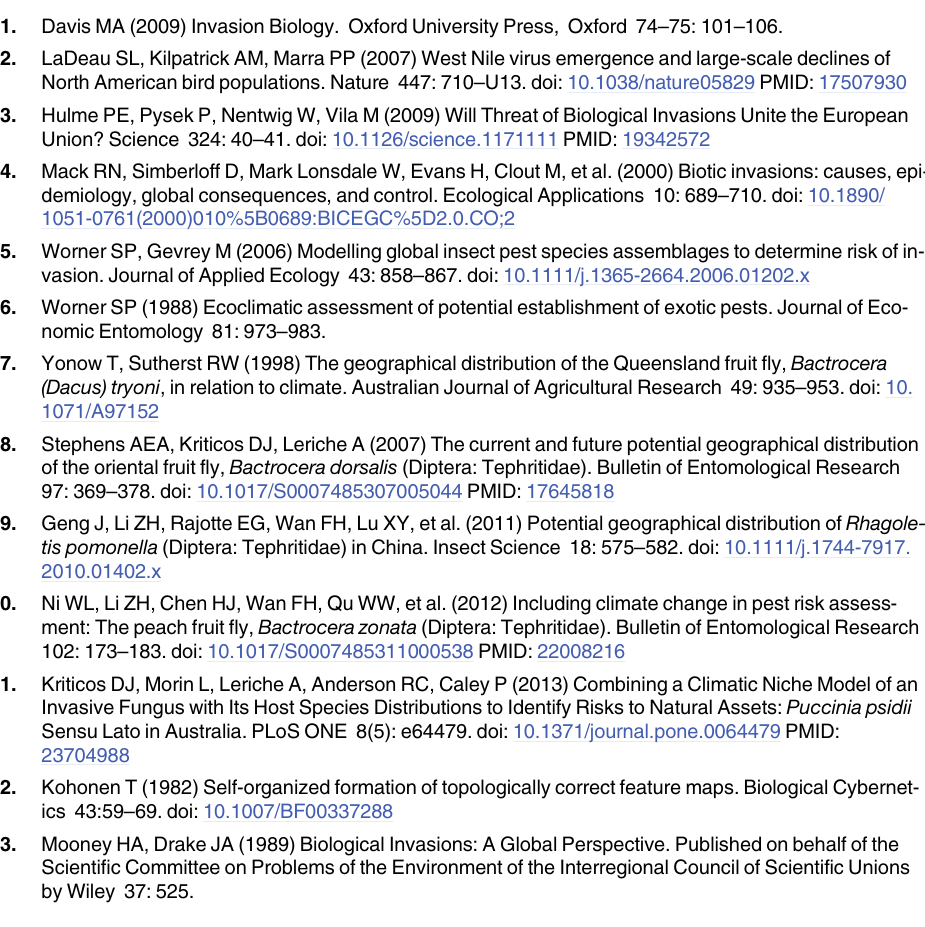
S1 Table. SOM indices of fruit fly species for each country (species only included if absent from a country and a known pest of a commercially grown host in that country). S2 Table. The countries assigned to the same neuron in the SOM analysis (i.e. those coun- tries with the most similar